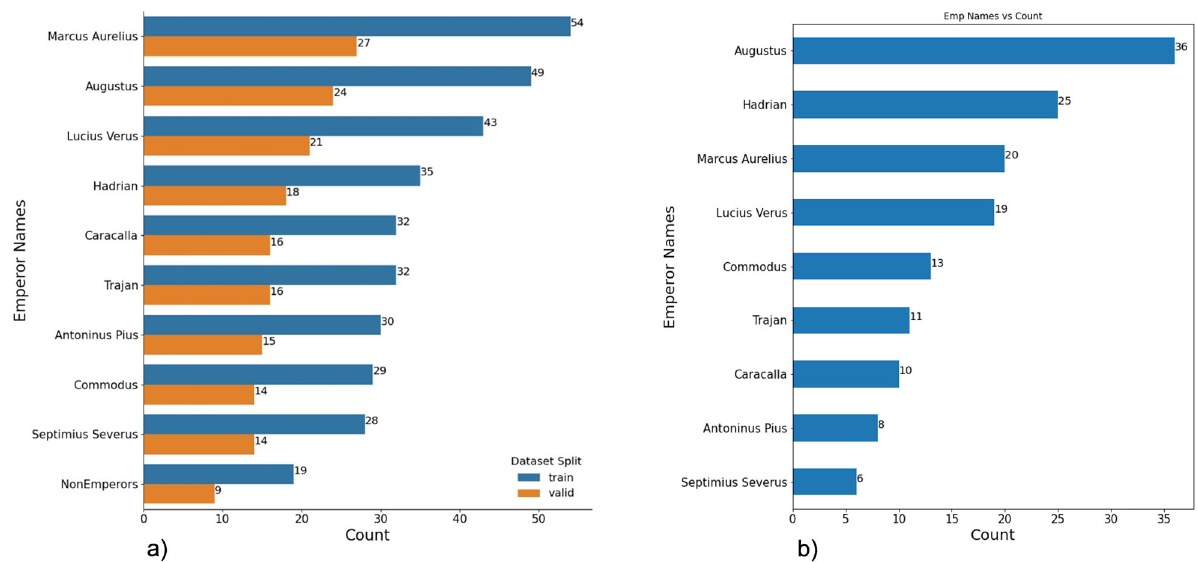
Fig. 4 Dataset information. a Training, validation and b testing sets. As our dataset is imbalanced, the dataset is split in a way that the training and validation datasets have similar subdivision between emperors and the non-emperors class. Testing set is chosen randomly and is not split in a strati fi ed manner for some classes.